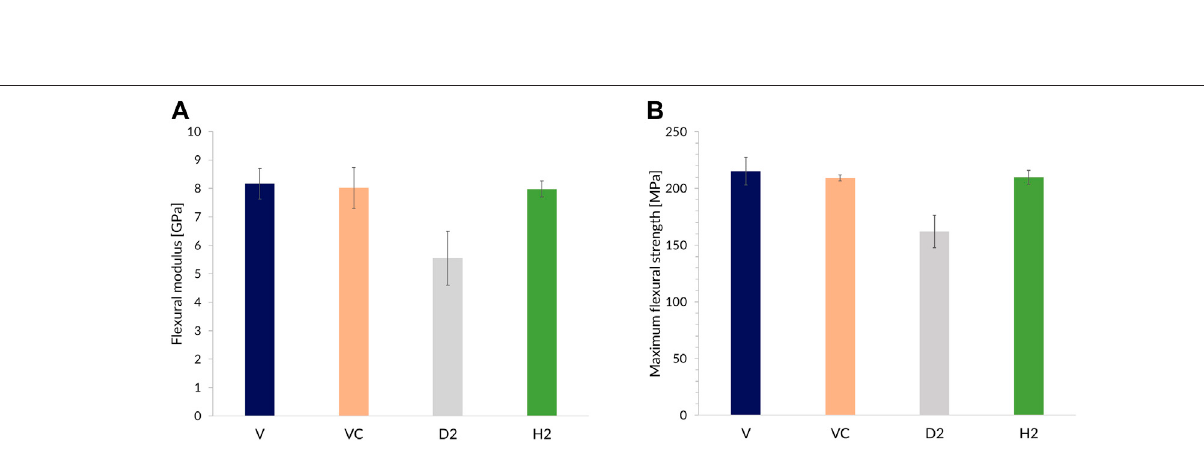
Frontiers in Materials |